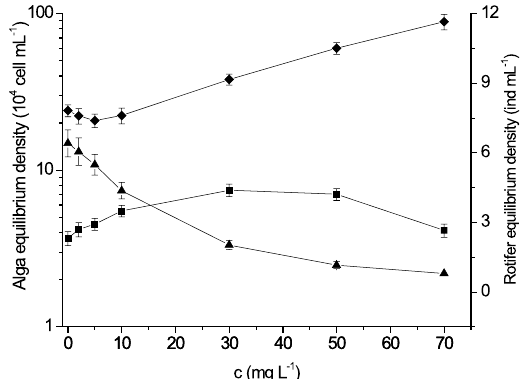
Figure 4. Changes of plankton equilibrium density with Ciprofloxacin hydrochloride concentration in the customized plankton community toxicity test (the dots displaying were mean values and the error bars stood for ◆ standard deviations; ■ : P. subcordiformis ; : I. galbana ; ▲ : B. plicatilis